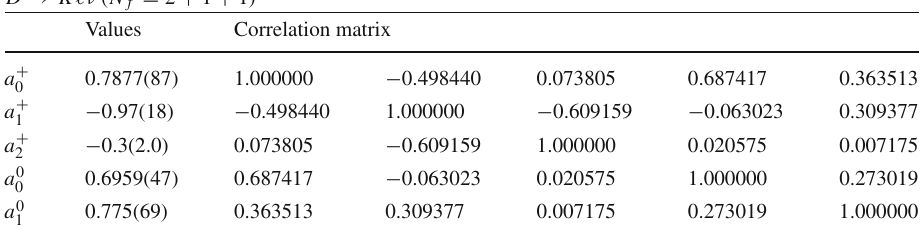
Table 36 Coefficients for the N + = 3 , N 0 = 3 z -expansion of the N f = 2 + 1 + 1 FLAG